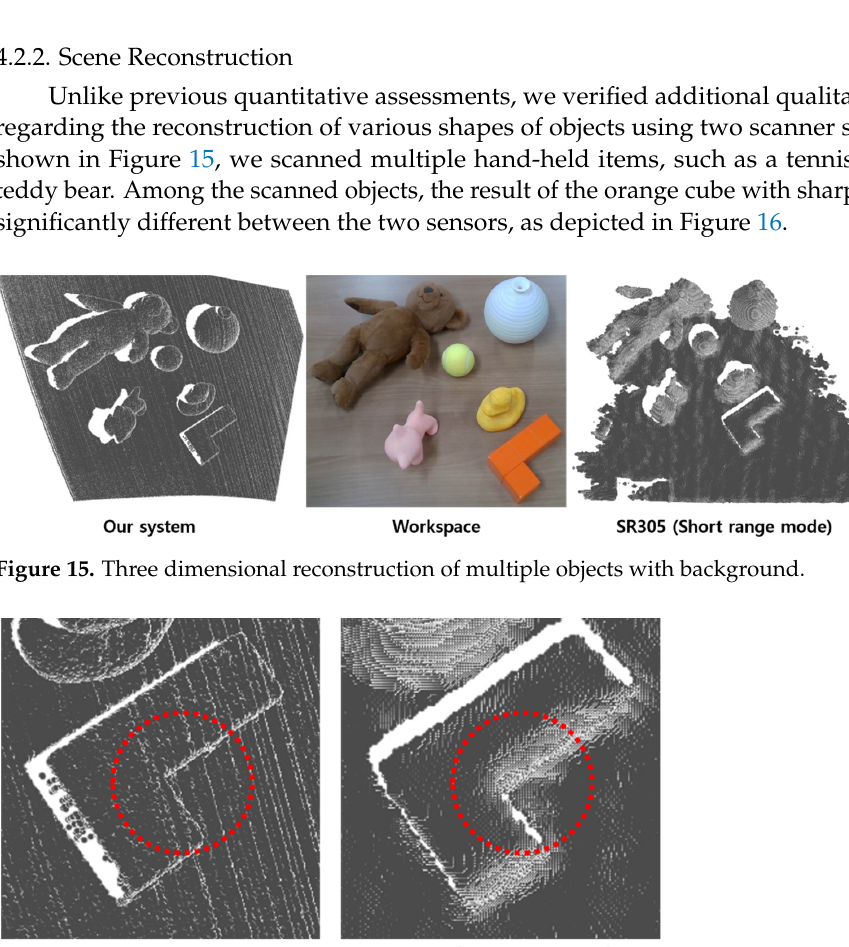
Figure 14. Distance errors from the checkerboard plane to every point.